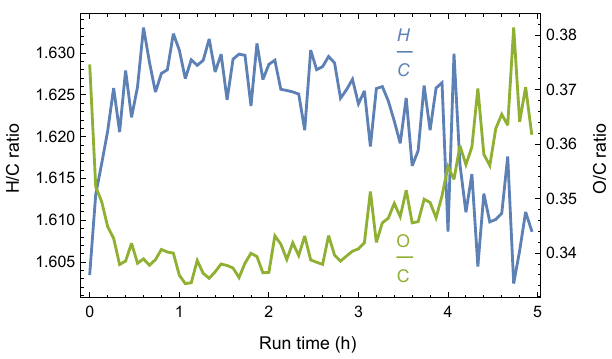
Figure 14. H / C and O / C ratios as a function of time for a typical α -phellandrene ozonolysis experiment (experiment 4).